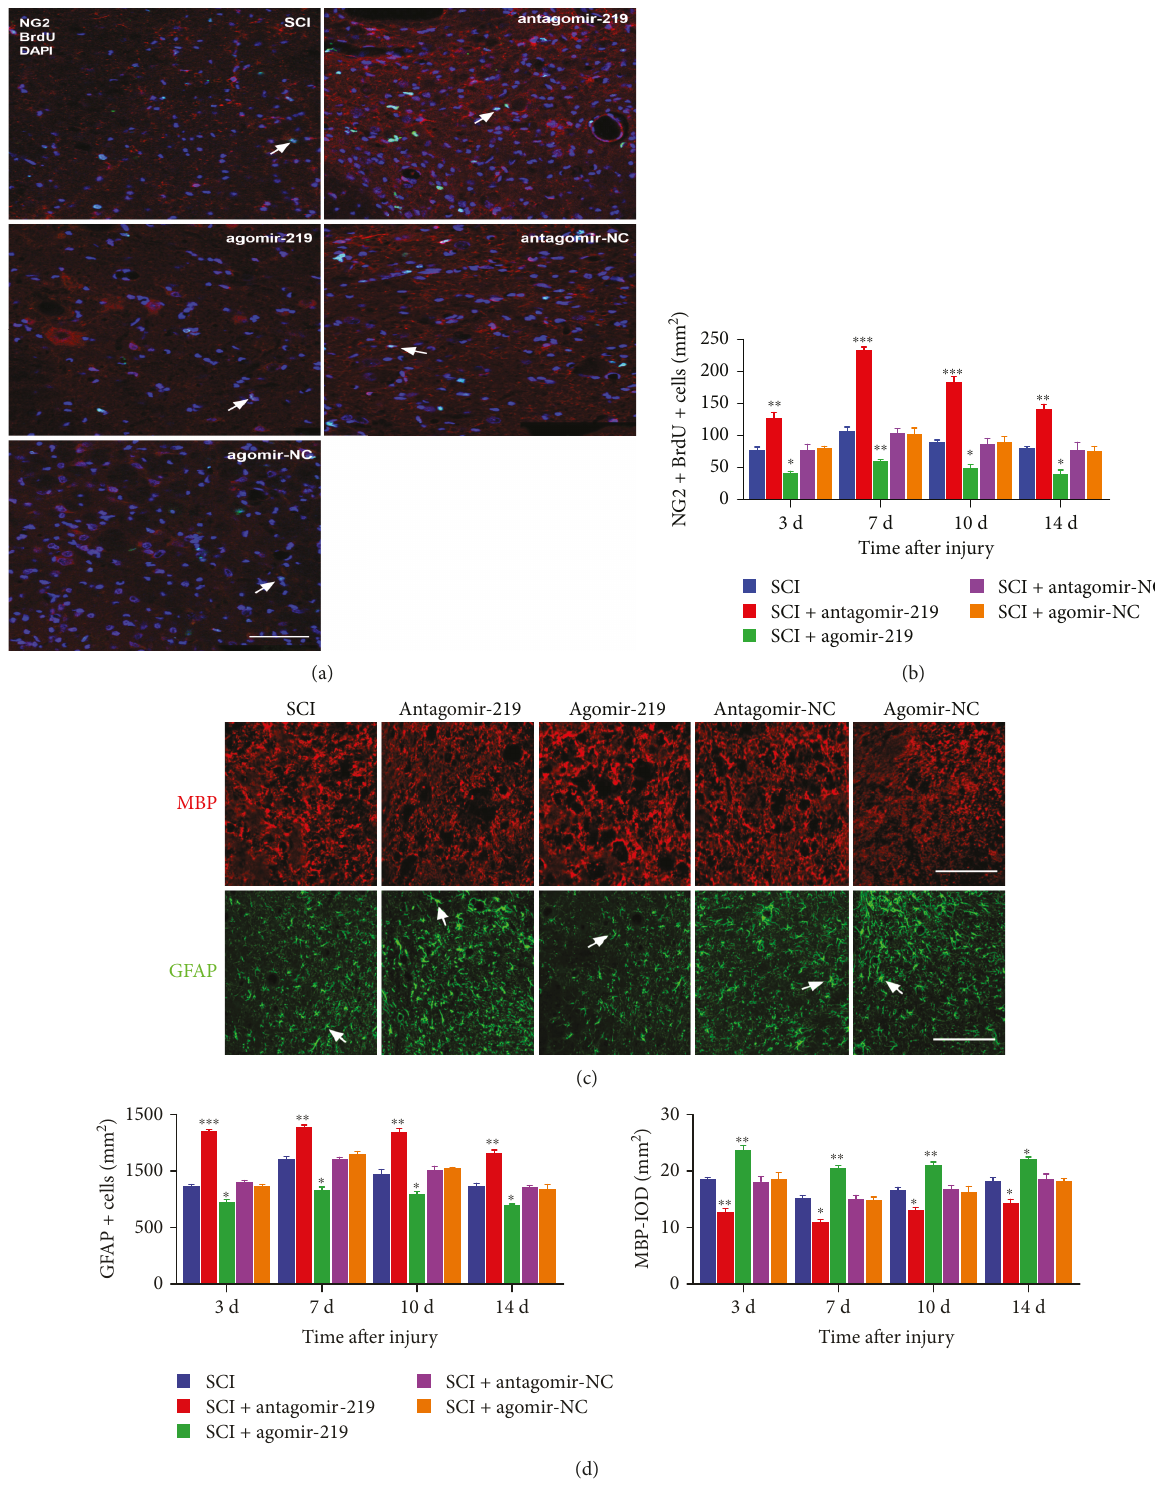
Figure 3: The e ff ects of miR-219 on the proliferation and di ff erentiation of OPCs (typical images at 7 days). (a, c) Typical images of NG2 +/BrdU+ OPCs, MBP+ oligodendrocytes, and GFAP+ astrocytes in the SCI, antagomir-219, agomir-219, antagomir-NC, and agomir-NC groups, with NG2 (red), BrdU (green), DAPI (blue), MBP (red), and GFAP (green). (b, d) The quantitative data of NG2+/BrdU+ OPCs, MBP+ oligodendrocytes, and GFAP+ astrocytes, respectively, at days 3, 7, 10, and 14 in the SCI, antagomir-219, agomir-219, antagomir-NC, and agomirNC groups. ∗ p < 0 05 , ∗∗ p < 0 01 , and ∗∗∗ p < 0 001 . Scale bar =50 μ m. OPCs: oligodendrocyte precursor cells; MBP: myelin basic protein; GFAP: glial fi brillary acidic protein; BrdU: bromodeoxyuridine; NC: negative